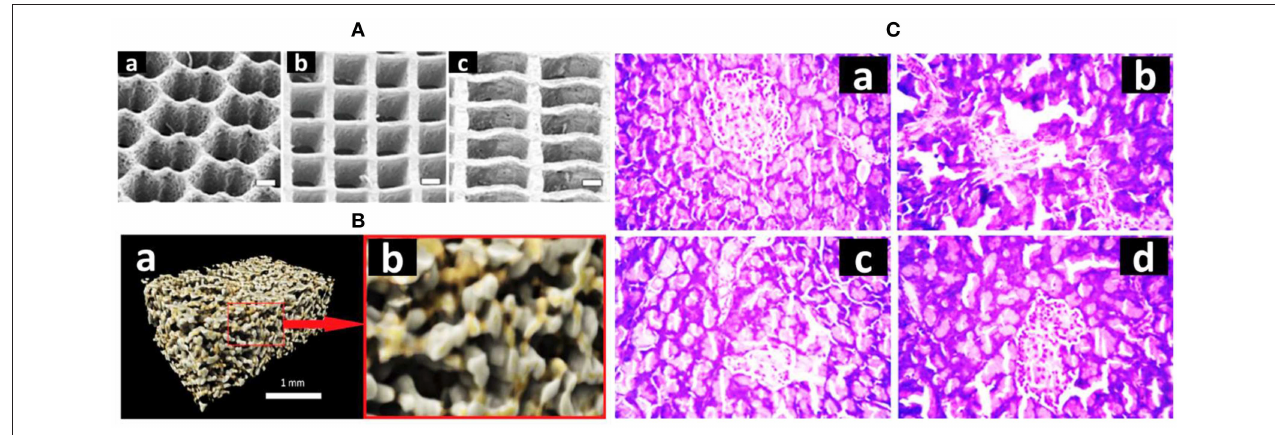
FIGURE 2 | (A) Three synthetic 3D scaffolds in different shapes: a honeycomb, a square, and a rectangle (adopted from Engelmayr et al., 2008). (B) Computer-rendered images of composite scaffold showing (a) a porous structure of the scaffold in 3D and (b) a zoomed section to better display the pore network (1mm across) (adopted from Hatton et al., 2019). (C) Histopathology examination of pancreas sections—(a) normal pancreas, (b) diabetic pancreas, (c) silybin (Sb)-treated pancreas, (d) Sb nanoparticle-treated pancreas (adopted from Das et al.,